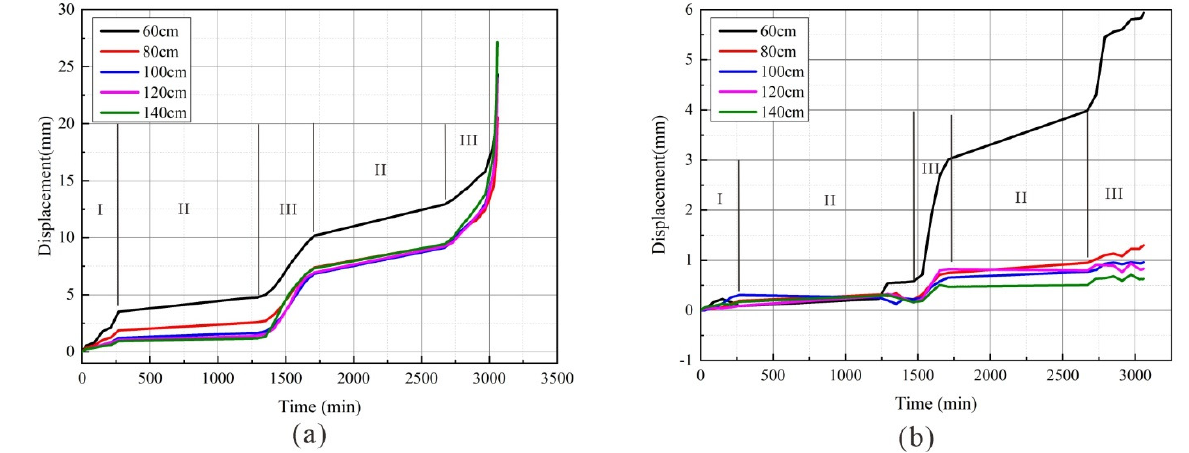
Figure 8. Displacement magnitudes of the slope at different depths (60 cm, 80 cm, 100 cm, 120 cm, 140 cm, corresponding to the vertical distance from the top of the slope): ( a ) displacement of the slope front; and ( b ) displacement of the slope side.